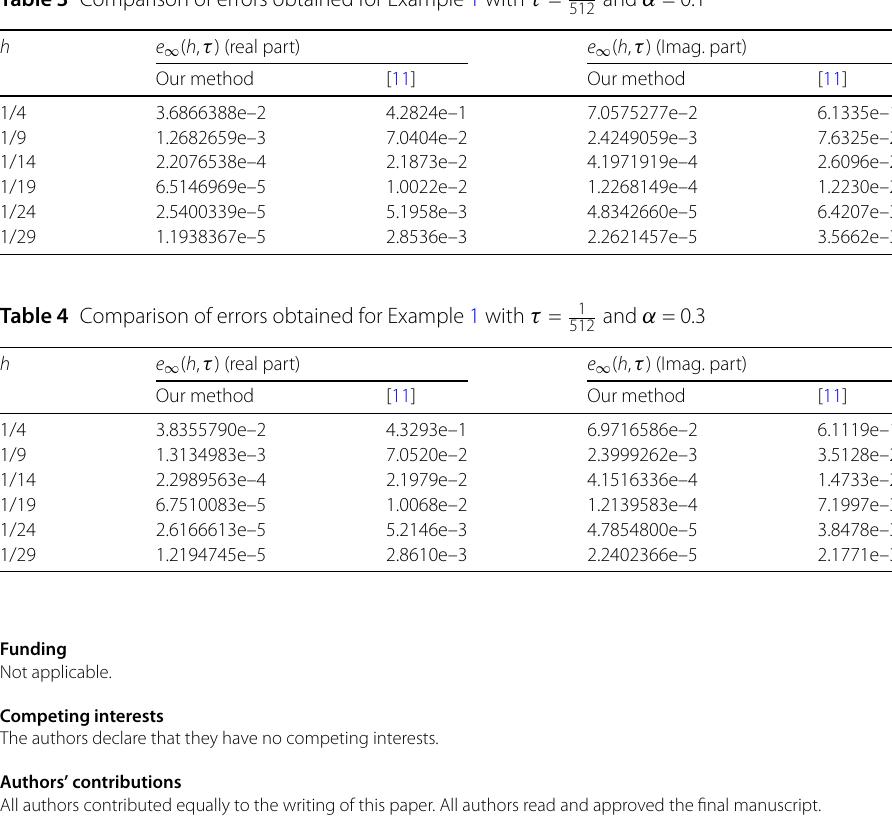
Table 3 Comparison of errors obtained for Example 1 with τ = 1